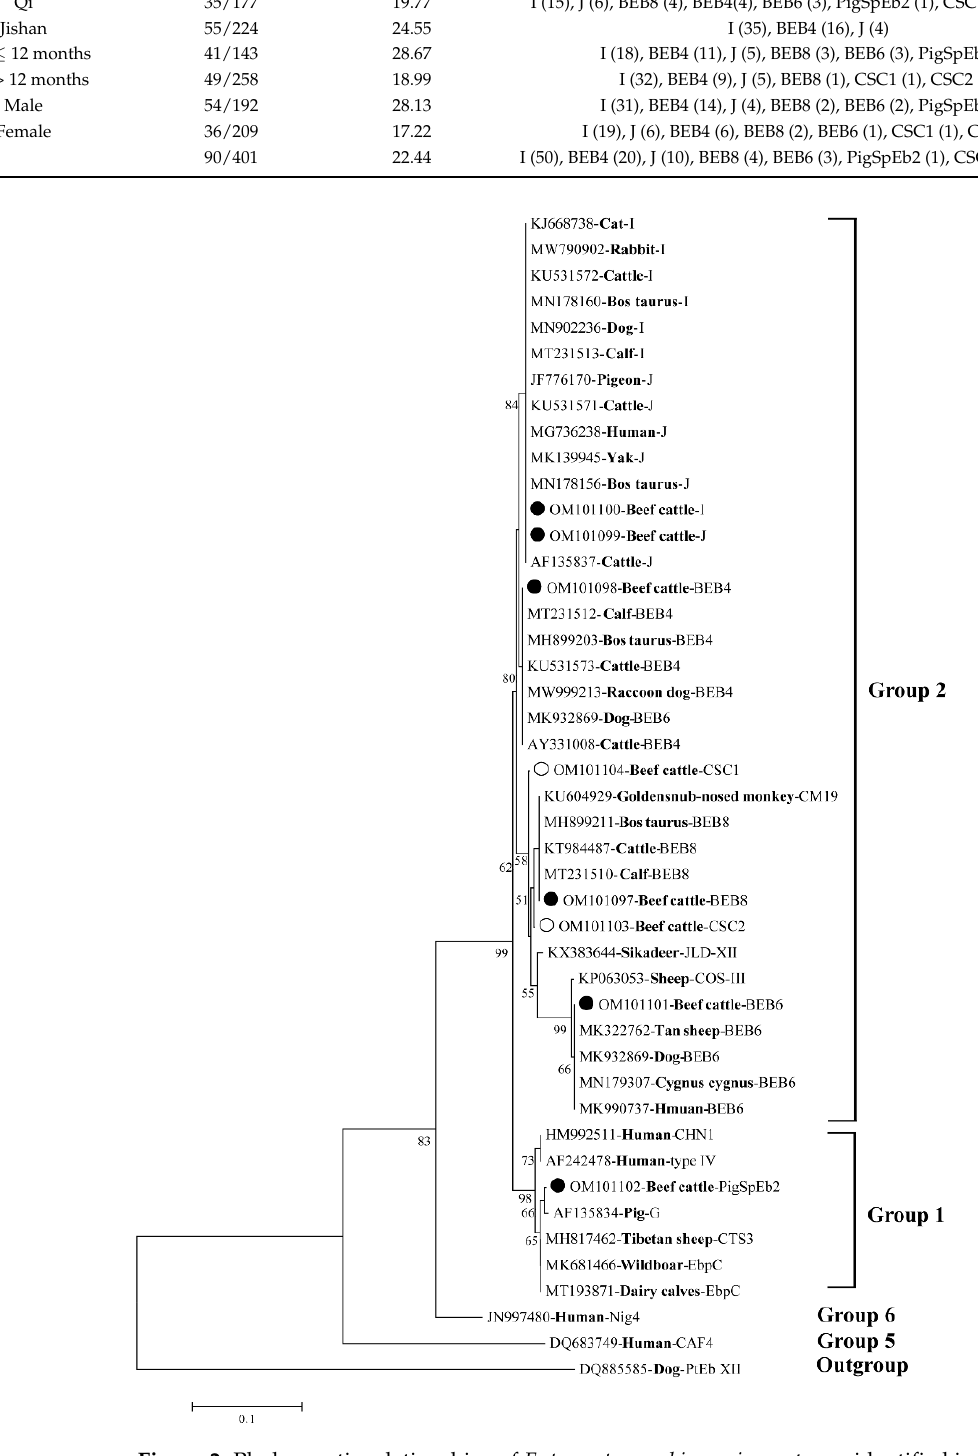
Figure 2. Phylogenetic relationships of Enterocytozoon bieneusi genotypes identified in this study and in previous reports. The six known genotypes and two novel genotypes identified in this study are marked with black circles and unfilled circles, respectively. Numbers on branches are the percentage of bootstrap values from 1000 replications.